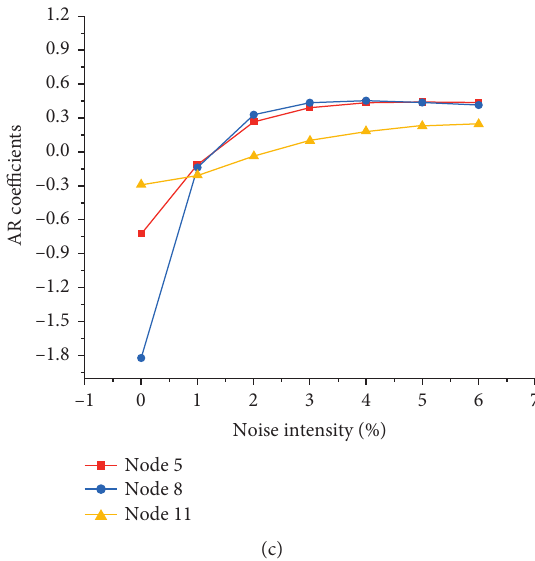
Figure 10: Comparison of the first three-order AR coefficients of noise-corrupted data and noise-free data: (a) first-order AR coefficients; (b) second-order AR coefficients; (c) third-order AR coefficients. Table 8: The identification results of damage locations when one brace is damaged with noises. Damage scenarios a j (%) T ( ° C)